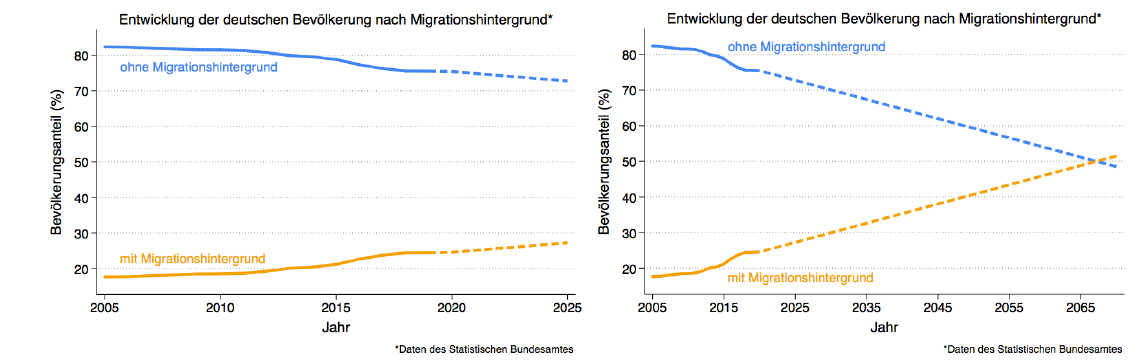
Figure 1: Control (left) and treatment (right) graphs showing actual and projected demographic change in Germany. Blue lines depict the percentage of the German population without migration background, and orange lines depict the percentage with migration background. The solid portion of the lines depict actual figures from the German Federal Statistical Office. The dashed portions of the line depict linear extrapolations to 2025 and 2065,